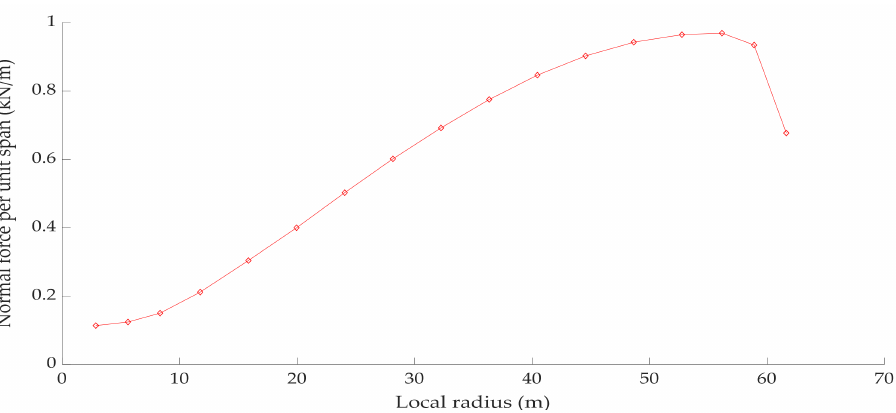
Figure 5. Normal force per unit span as a function of the local